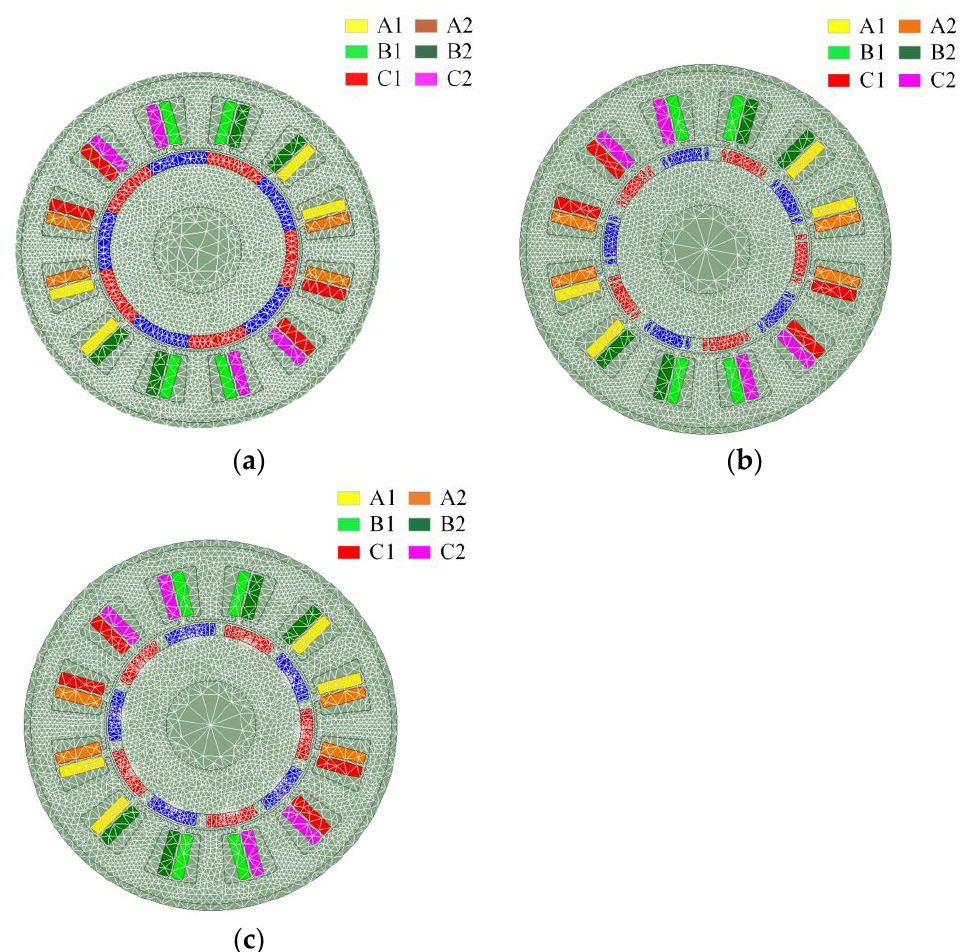
Figure 10. Mesh generation: ( a ) conventional surface-mounted PM shape; ( b ) equivalent sinusoidal PM shape; ( c ) equivalent sin + 3rd PM shape.